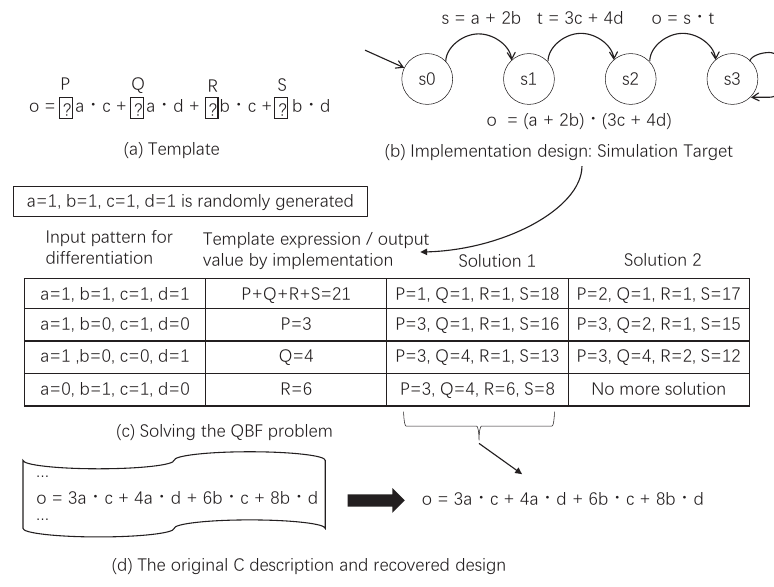
Figure 9. A solving process for the example in Figure